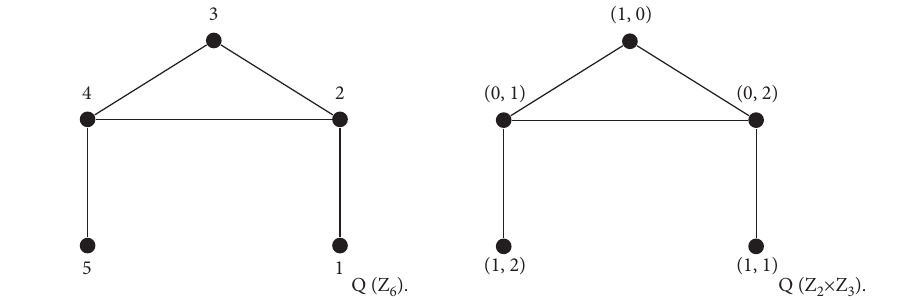
Figure 5: Quasiregular graphs of two isomorphic rings.